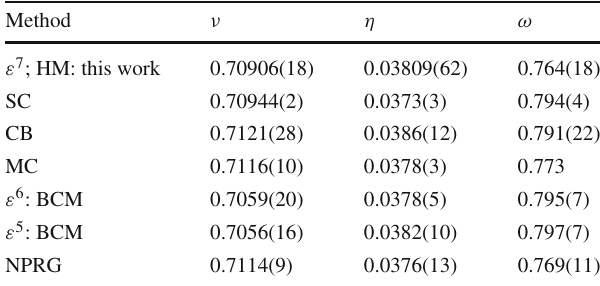
Table 4 The seven-loop ( ε 7 ) hypergeometric-Meijer resummation for the exponents ν , η and ω of the O ( 3 ) -symmetric model. Also we list the SC resummation results from Ref. [54]. The recent results from conformal bootstrap calculations are listed also where the values of ν and η are taken from Ref. [26] while ω from Refs. [25,32]. For MC simulations ω is taken from from Ref. [17] while ν and η are taken from from Ref. [13]. The six-loop BCM resummation is taken from Ref. [32] and five-loops from same reference. As in all of above tables, we list in the last row the very recent calculations from NPRG method [28] (up to O (∂ 4